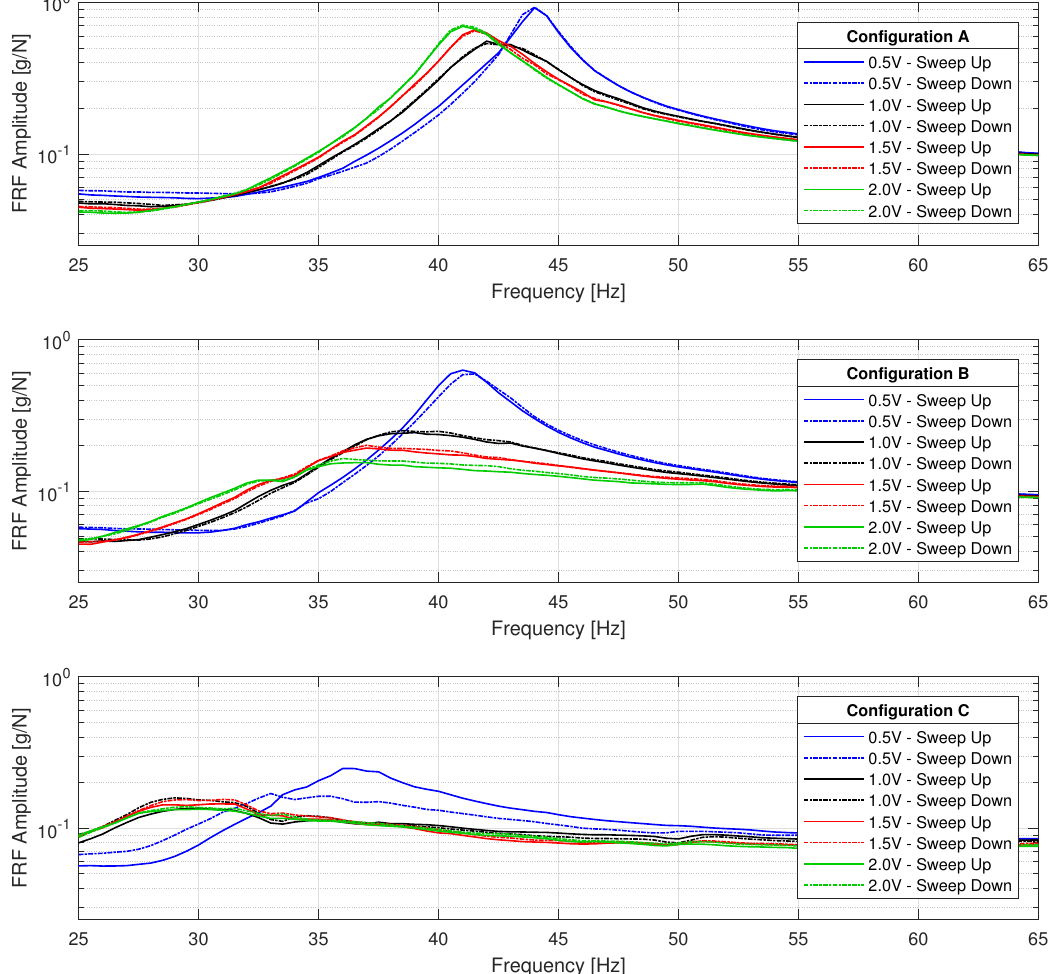
Figure 6. Comparison of the sweep up and down excitation for each amplitude level for configuration A ( top ), B ( middle ) and C ( bottom